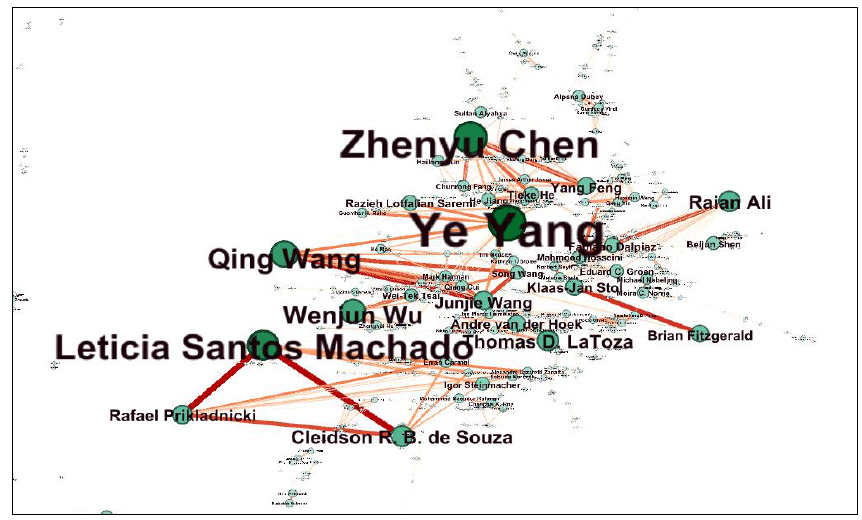
Figure 4. Tie strength in CSE co-authorship networks. Table 4. The most frequently occurring co-author